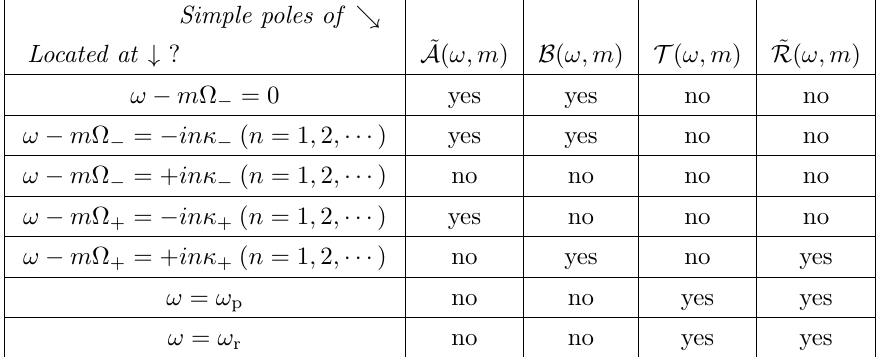
Table 1 . Location of simple poles of relevant scattering coe(cid:14)cients. The prograde ( ! p ) and retrograde ( ! r ) exterior quasinormal frequencies are given in